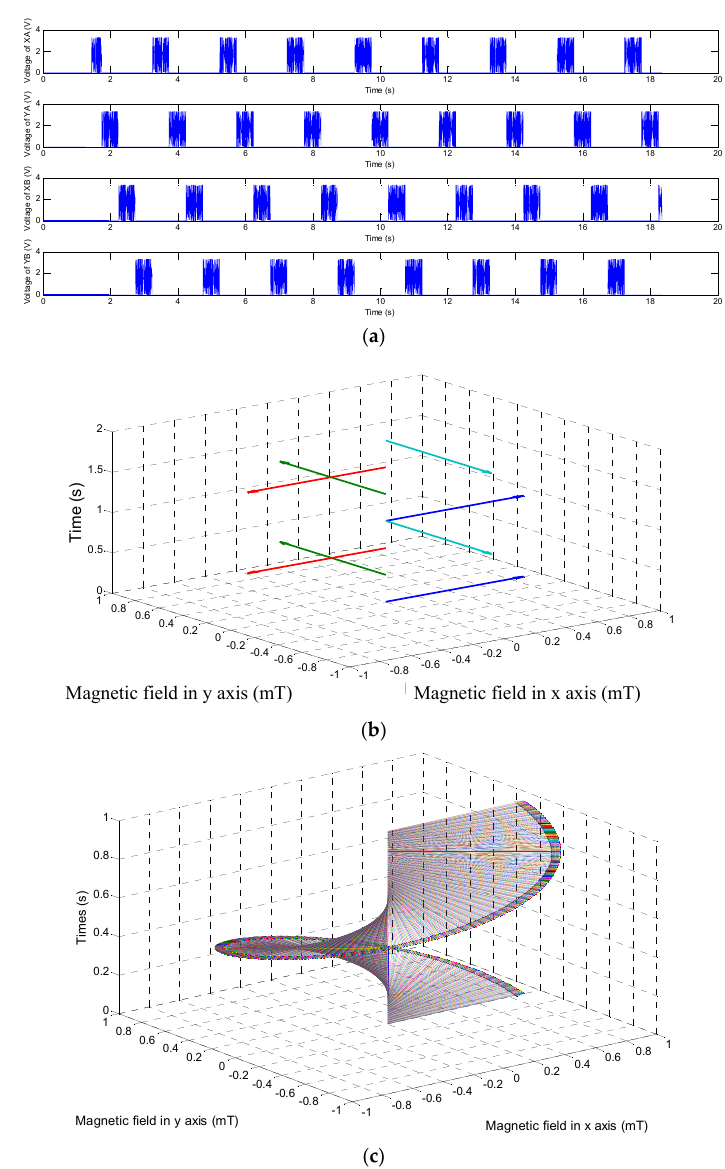
Figure 8. ( a ) Input square wave signals of driving system; ( b ) Rotational magnetic field with square wave signals, ( c ) Rotational magnetic field with sine wave signals.